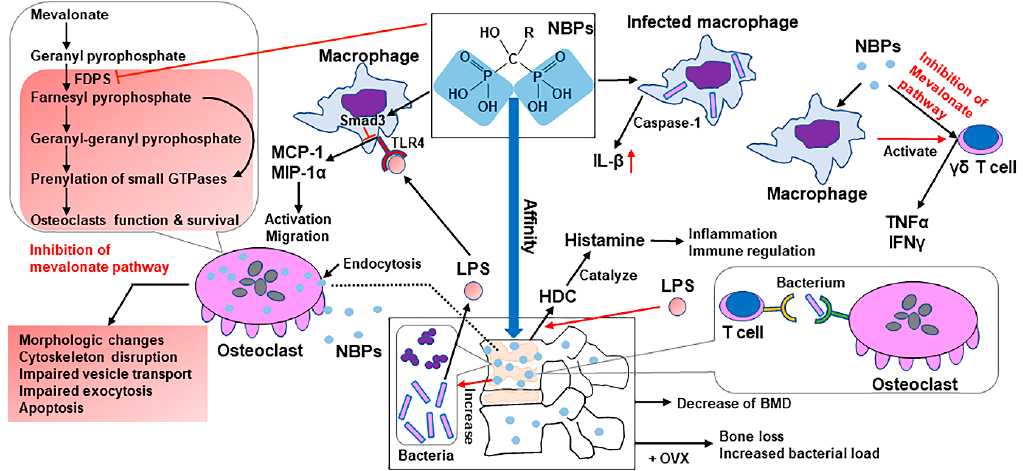
Figure 3. The molecular mechanisms of the effects of nitrogen-containing bisphosphonates (NBPs) on pyogenic osteomyelitis. BMD, bone mass density; FDPS, farnesyl diphosphate synthase; HDC, histamine-forming enzyme histidine decarboxylase; IFN- γ , interferon- γ ; IL-1 β , interleukin-1 β ; LPS, lipopolysaccharide; MCP-1, monocyte chemoattractant protein-1; MIP-1 α , macrophage inflammatory protein-1 α ; OVX, ovariectomy; TLR4, Toll-like receptor 4; TNF α , tumor necrosis factor α .